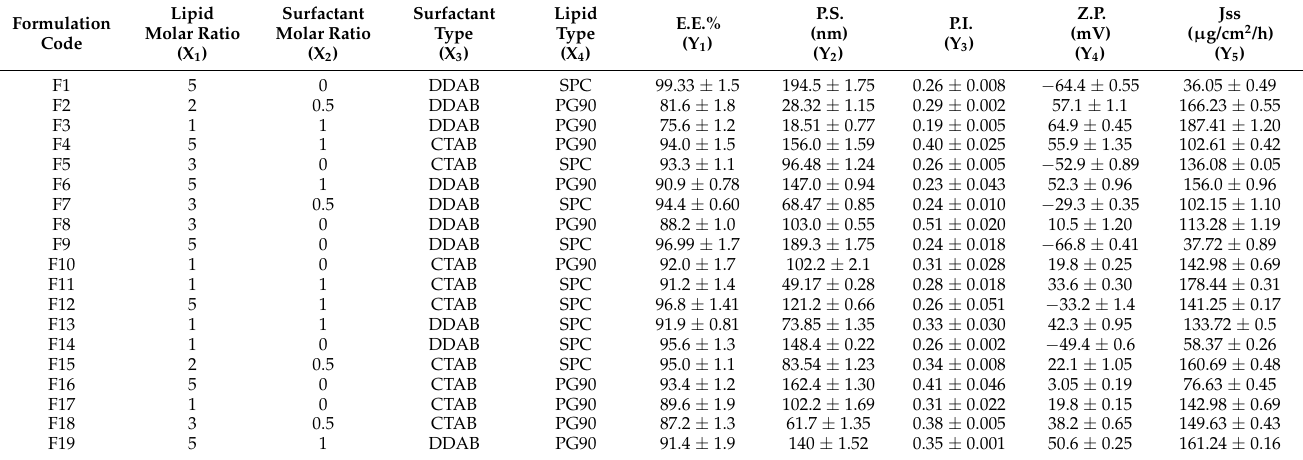
Table 2. Experimental runs, independent variables, and measured response of the DOD of VAN- loaded LPX.